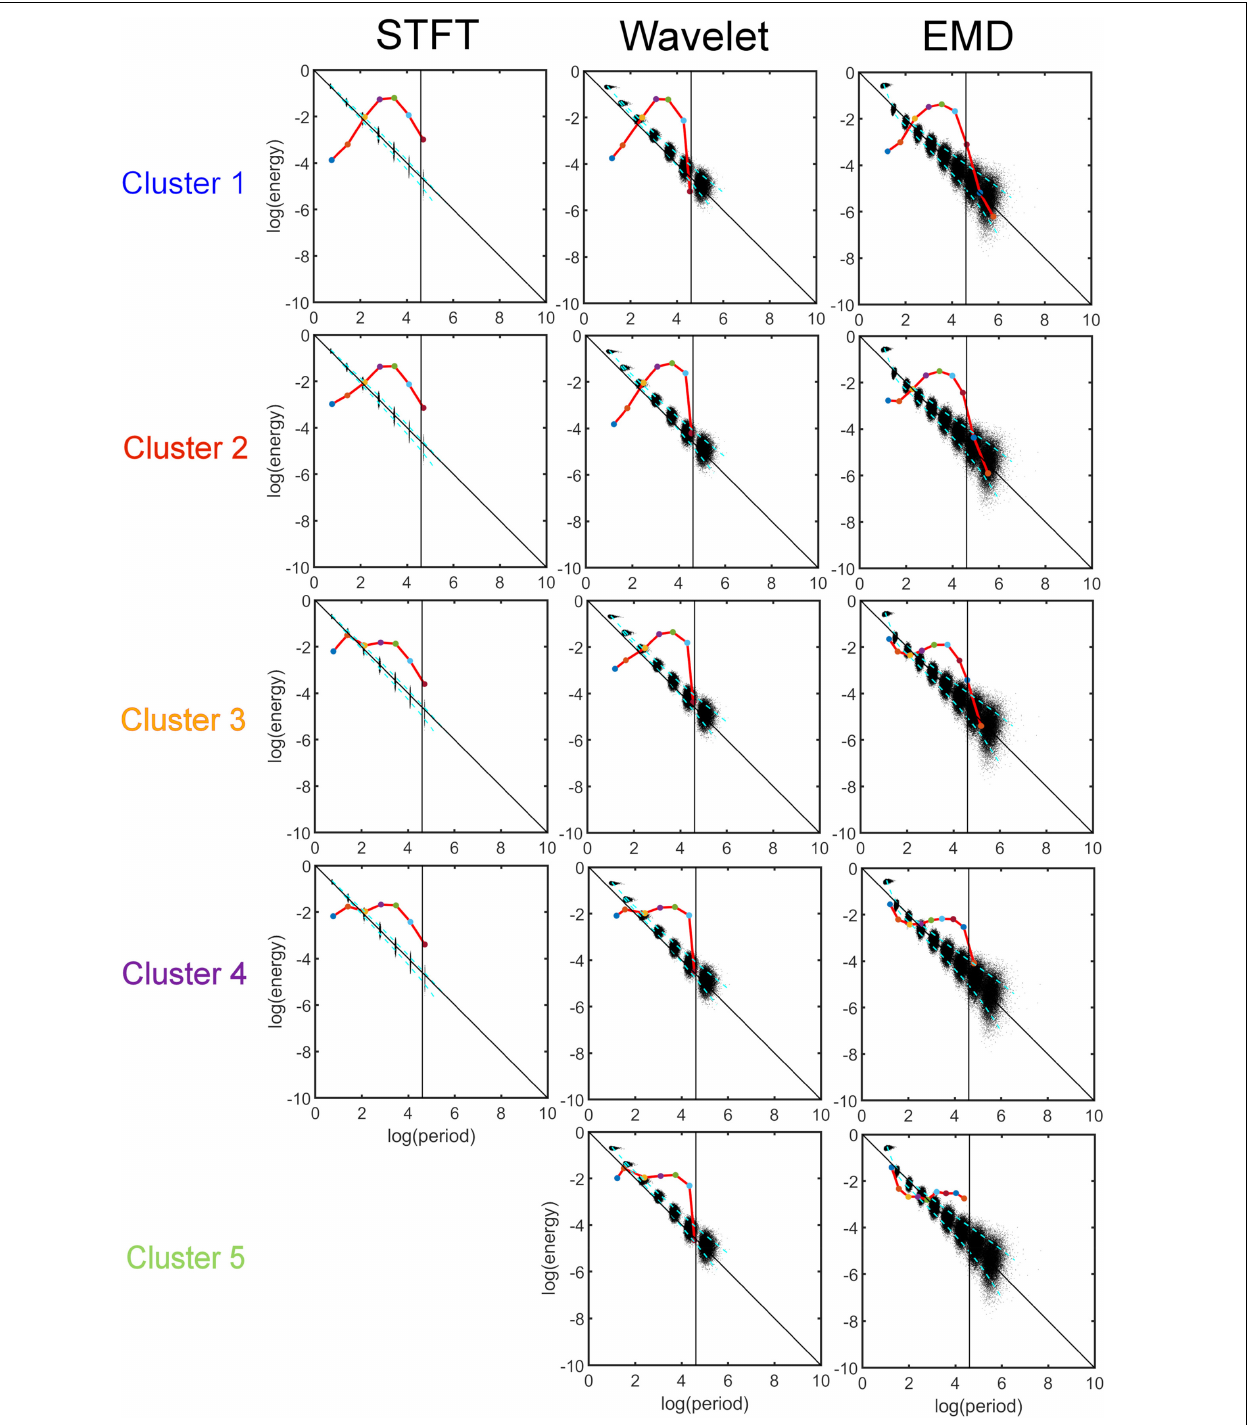
FIGURE 8 | K-means clustering of the energy-period profiles for all 30 ICA components, where each ICA time series was decomposed into components using three different analysis methods (Short-Time Fourier Transform (STFT), Maximal Overlap Discrete Wavelet Transform (MODWT), and Empirical Mode Decomposition (EMD)). The vertical black line indicates the frequency cut-off value of 0.01 Hz, and the black dots indicate the profile of Gaussian white noise. The red line for STFT and Wavelet consists of 6 components each, whereas the redline of EMD spans 9 IMFs. Summary: Note that STFT and Wavelet use the same number (i.e., 7) of decompositions to reach the 0.01 Hz line for all clusters. EMD, however, is cluster-specific and adapts its number of IMFs to the frequency content of the clusters. Thus, EMD uses 7 IMFs to reach the 0.01 Hz line for the low-frequency cluster 1, and 9 IMFs for the high-frequency cluster 5. For clusters 2 to 4, the number of IMFs used by EMD is in-between, depending on the frequency content of the